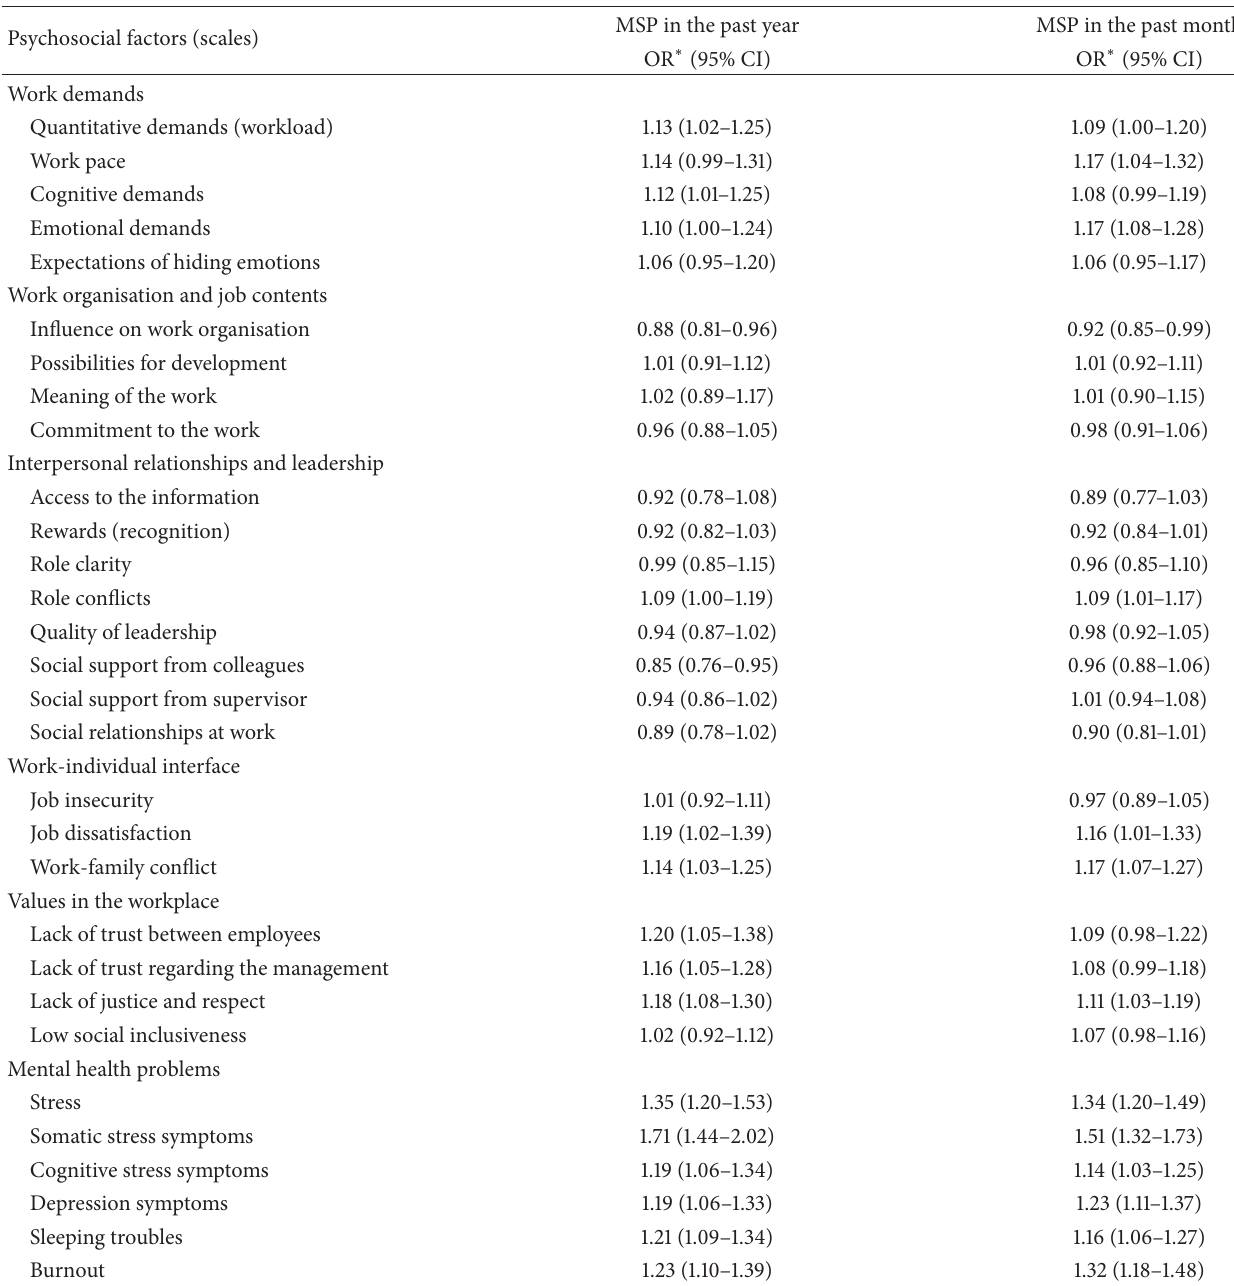
Table 4: Associations with musculoskeletal pain in past year and